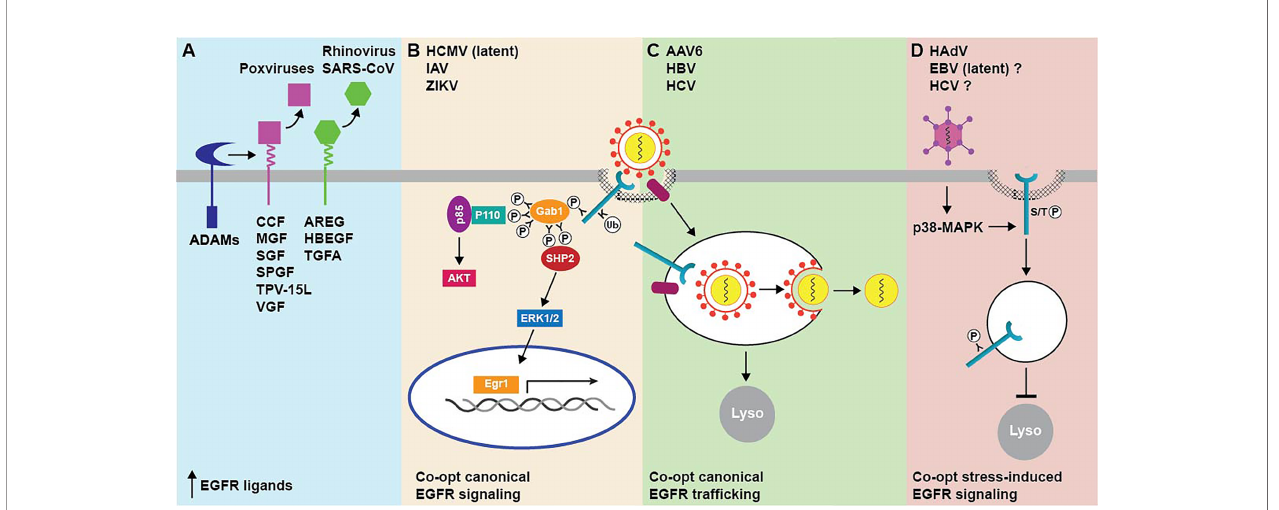
FIGURE 2 | Summary of mechanisms for targeting EGFR by animal cell viruses. (A) EGFR activity is regulated by EGF-like growth viruses encoded by multiple poxviruses (magenta), and by up-regulated expression of endogenous EGFR ligands (green) following infection with some respiratory viruses. Mature growth factors released from membrane-bound precursors by host cell ADAMs subsequently act in autocrine and paracrine fashions. (B) Virus cell entry requires EGFR-triggered activation of downstream entry relevant signaling pathways, such as PI3K/Akt and ERK-MAPK. Both pathways are linked to EGFR via the Gab1 adaptor protein, which activates the p85 catalytic subunit of PI3K by modulating the conformation of the p110 regulatory subunit and also promotes sustained ERK/MAPK signaling downstream of SHP2. (C) EGFR facilitates cell entry by linking virus-host cell receptor complexes to endocytic machinery. In the case of enveloped viruses, this may enable traf fi cking to endocytic compartments with conditions that are favorable for membrane fusion events facilitating nucleocapsid release to the cytosol. (D) EGFR does not have a direct role in cell entry but is activated intracellularly in non-degradative endosomes downstream of virus-induced p38-MAPK